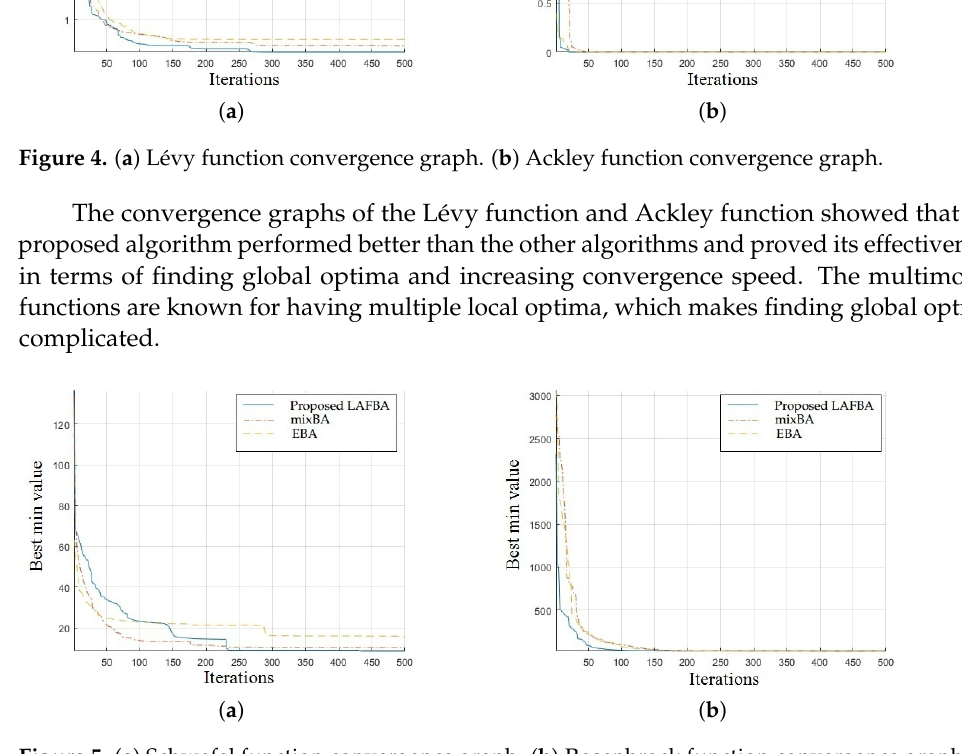
Figure 5. ( a ) Schwefel function convergence graph. ( b ) Rosenbrock function convergence